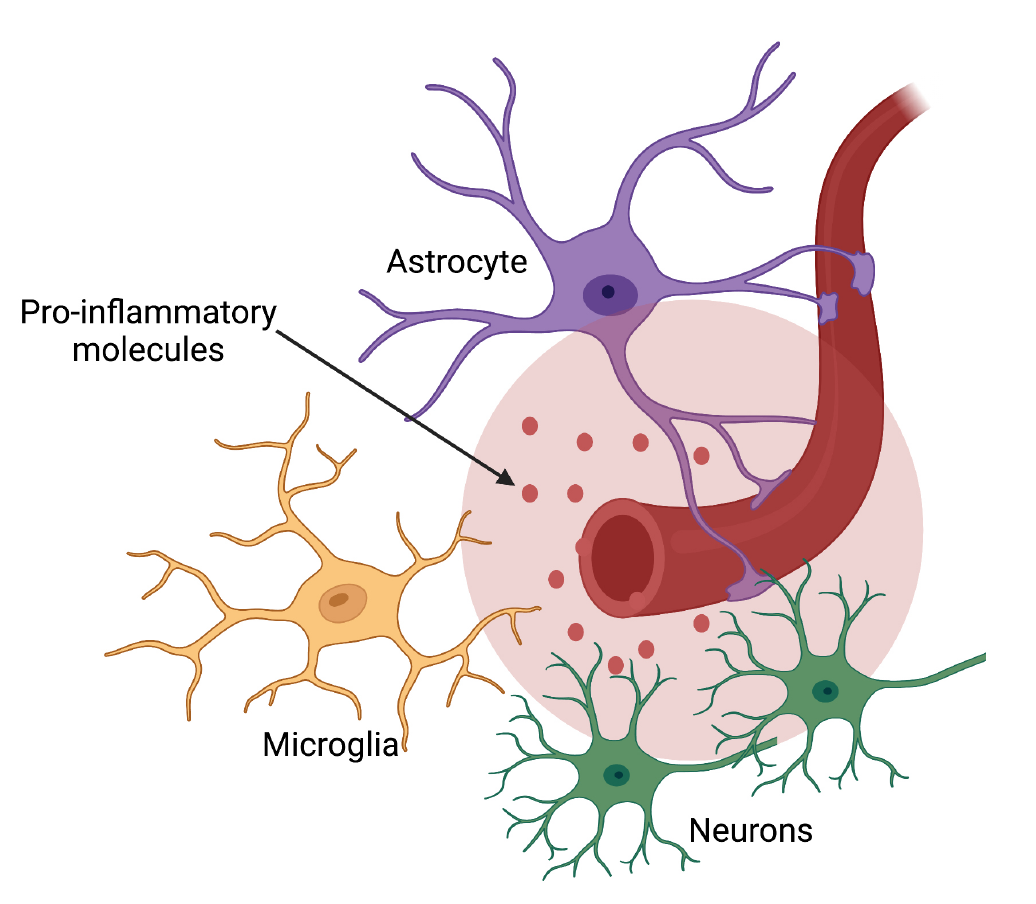
Fig.3. AsummaryofkeycellsinvolvedintheneurobiologyofinflammationassociatedwithPTH. The involvement of glial and immune cells, such as astrocytes and microglia, and secretion of pro-inflammatory molecules in post-traumatic headache after cervical damage can contribute to PTH formation by hyper-excitability and hyper-activity